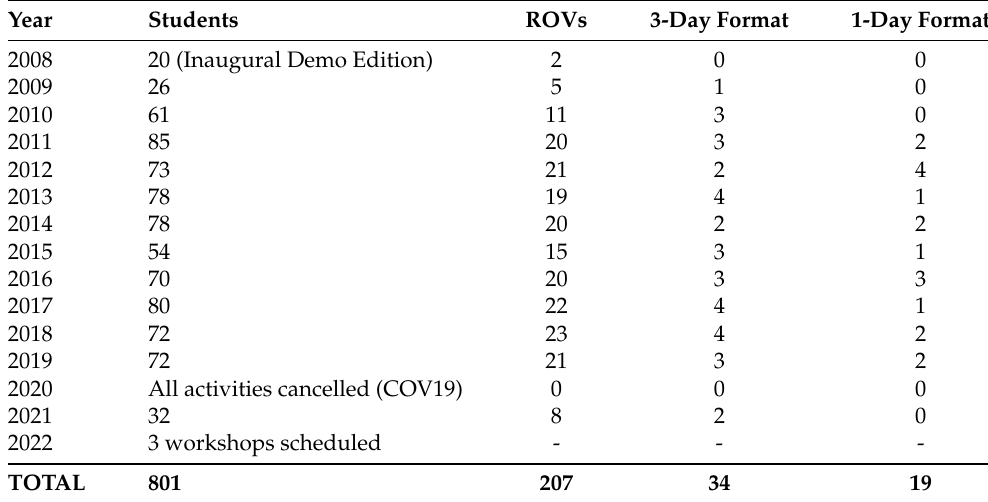
Table 4. Workshops done since November